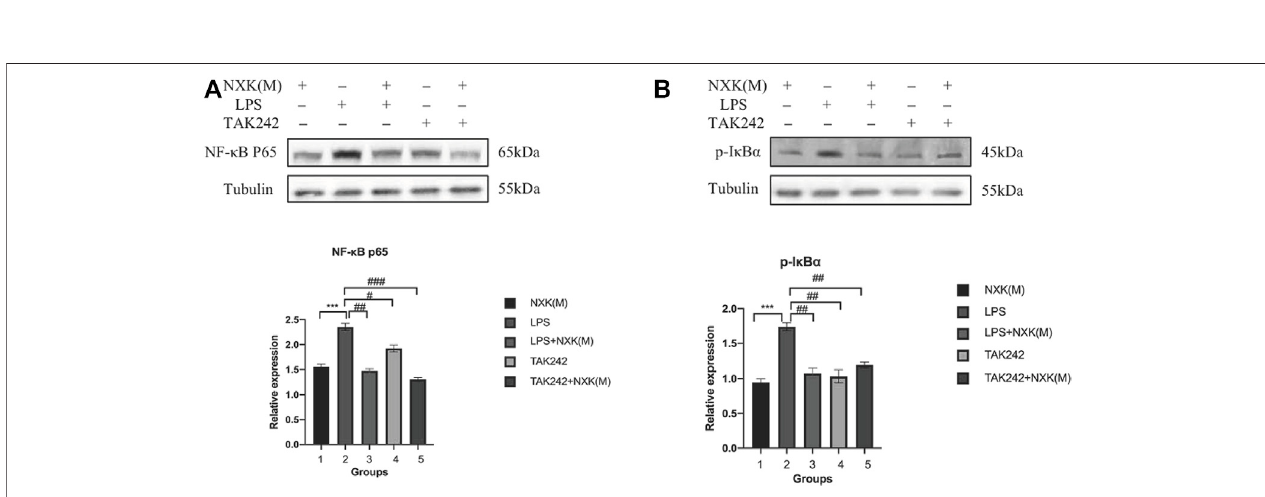
FIGURE 6 | Western blot analysis was used to measure the protein levels of NF- κ B p65 and P-I κ B α , treated by NXK (M), TAK242, and LPS. (A) Expression of NF- κ Bp65 protein in different mice groups. (B) Expression levels ofNF- κ Bp65 and P-I κ B α proteins in different groups ( n = 6per group).Quanti fi cation was performed after normalization to Tubulin. Values are shown as means ± SD, * p < 0.05, ** p < 0.01, *** p < 0.001, vs. LPS group.